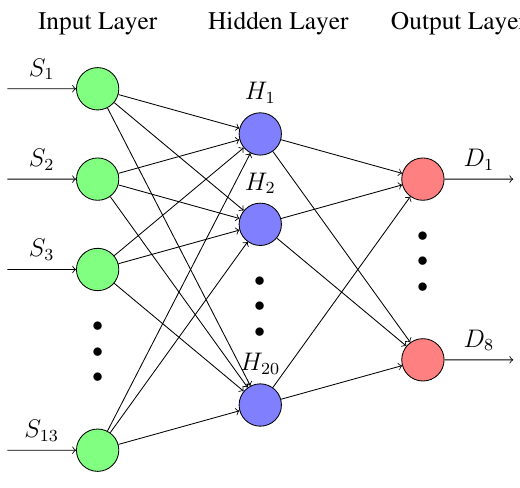
Figure 12. Artificial Neural Network implemented